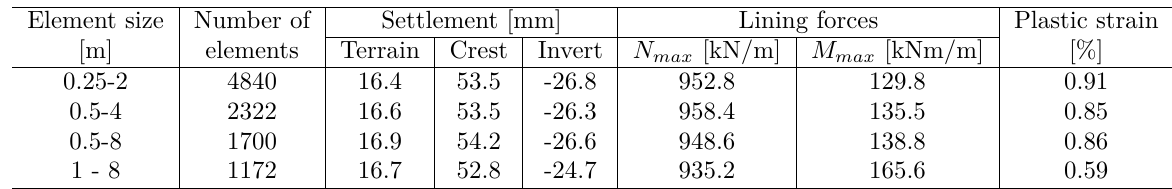
Table 2. Evolution of settlement and lining internal forces as a function of mesh density.